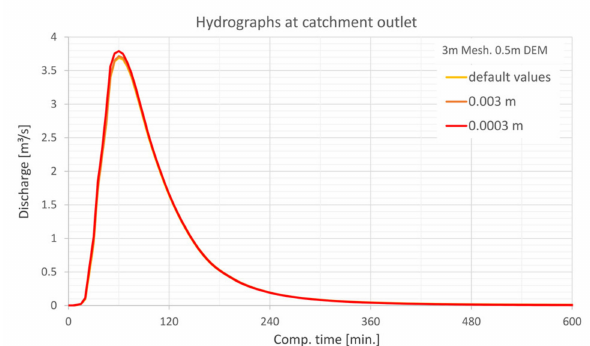
Figure 31. Qualitative comparison of the hydrographs and model sensitivity for the filter settings at the catchment outlet for 3 m mesh and 0.5 m DEM.